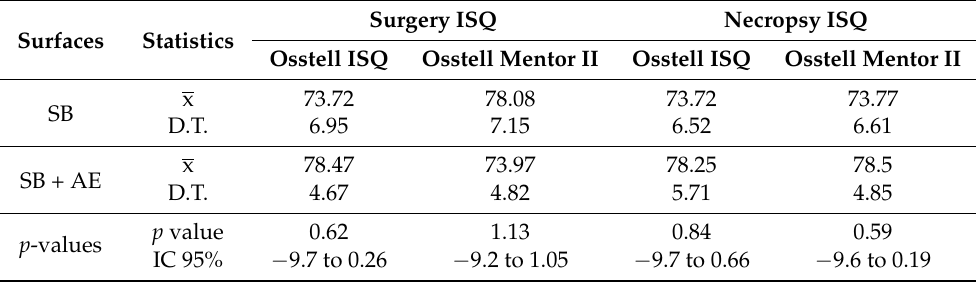
Table 5. Results of ISQ values obtained by the Osstell Mentor II and Osstell ISQ systems at surgery and sacrifice time on both surfaces (SB and SB +